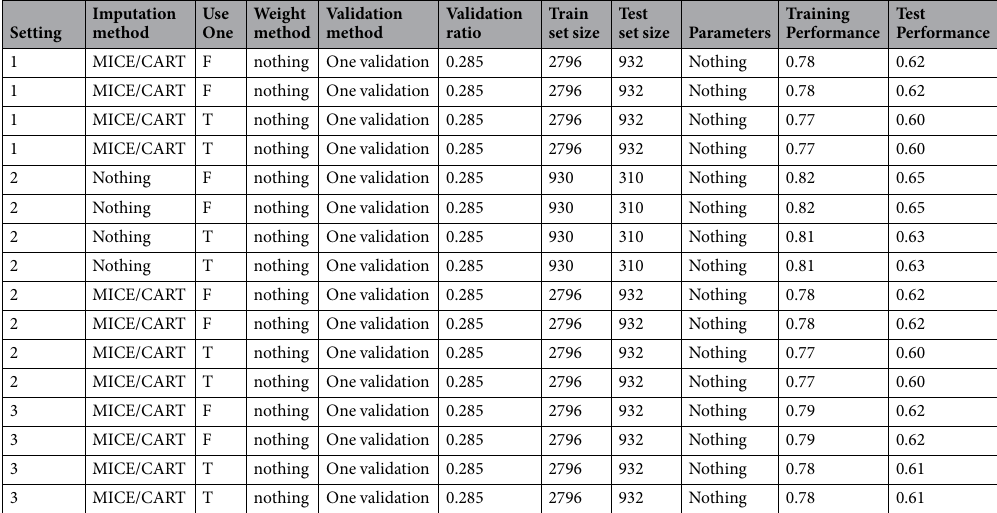
Table 6. Performance of the prediction model by survival cox regression analysis using different model setting. * Test performance were presented as concordance index for time to graft failure data. Model setting 1: Use overall attributes with multiple imputation. Model setting 2: Use attributes except DSA,